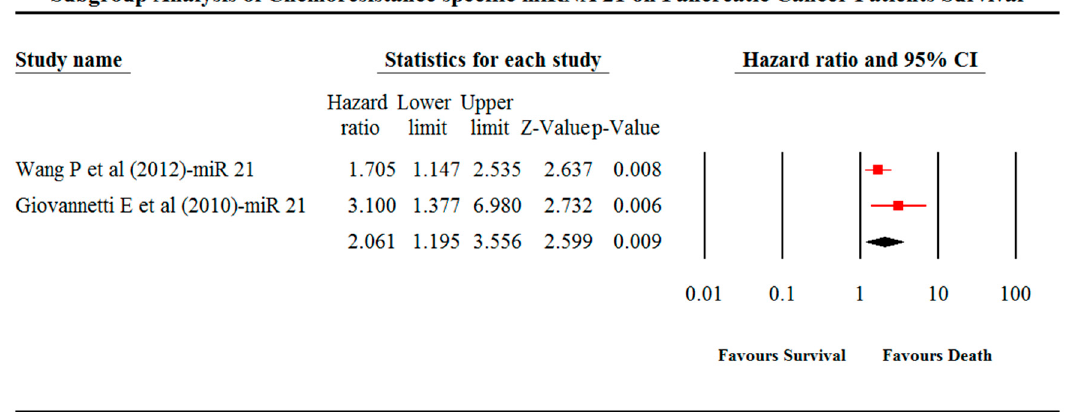
Figure 5. Forest plot of sub-group analysis for miRNA-21 of the included studies.